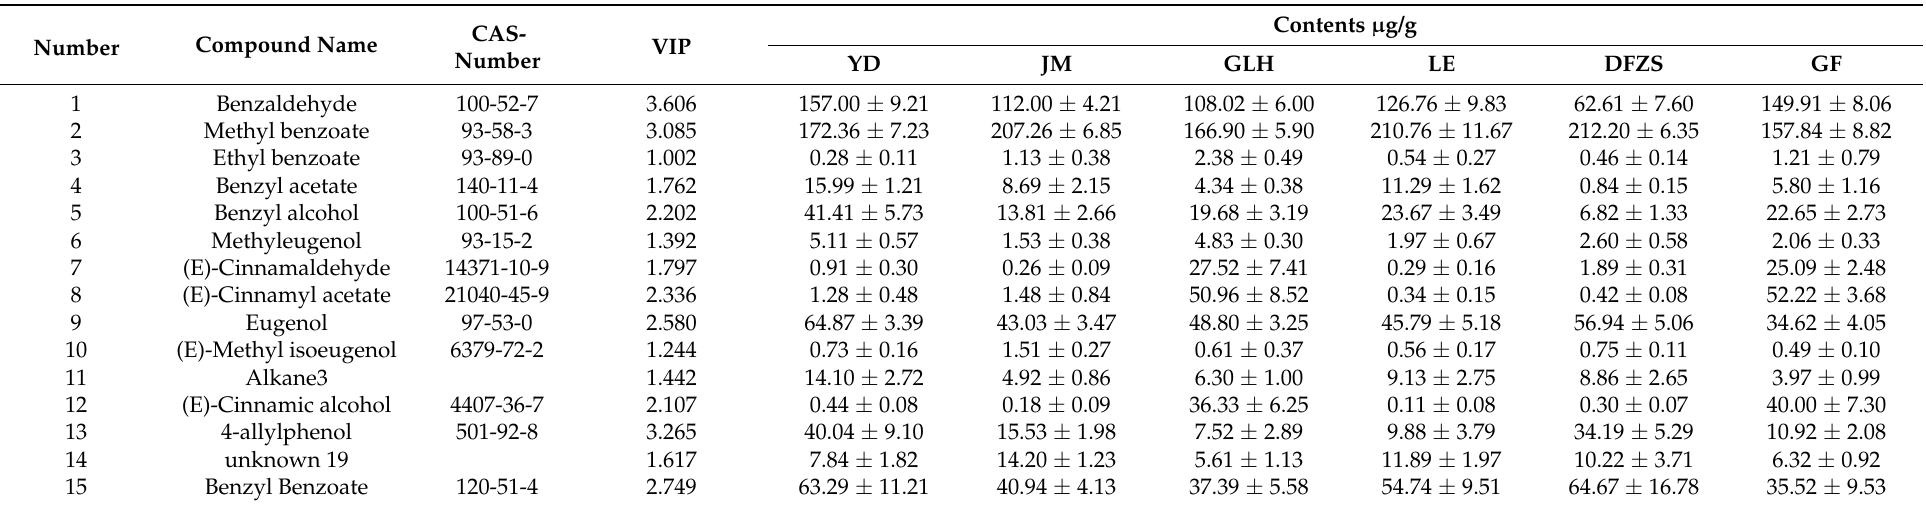
Table 2. Contents of fifteen differential volatile compounds in six cultivars of P. mume